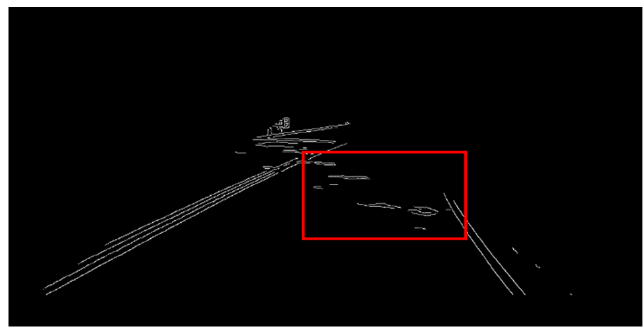
Figure 14. Fake edges caused by shadows/puddles.